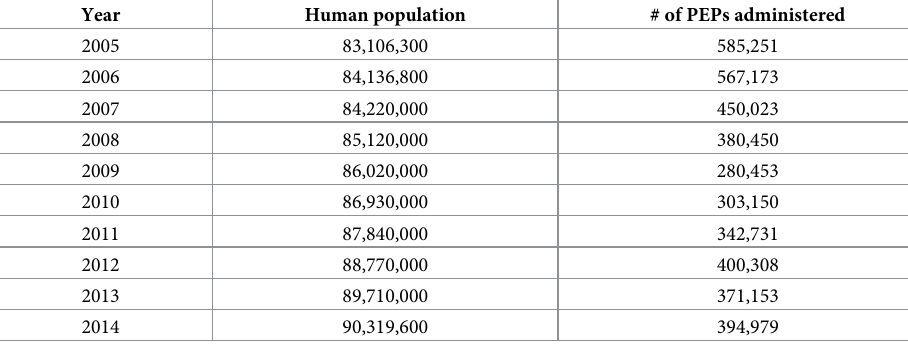
by 2011 we anchored 2005 (the initial study year) at 6 million and then grew the dog popula- tion at a steady rate of 0.5 million to achieve the 2011 population. Vaccination coverage is sim- ply the share of the total dog population that is comprised of vaccinated dogs. Reliable estimates of dog vaccination coverage were only available between 2011 and 2014. To estimate vaccination coverage for 2005 through 2010, we extrapolated values with a linear time trend and applied those values to the unknown years.